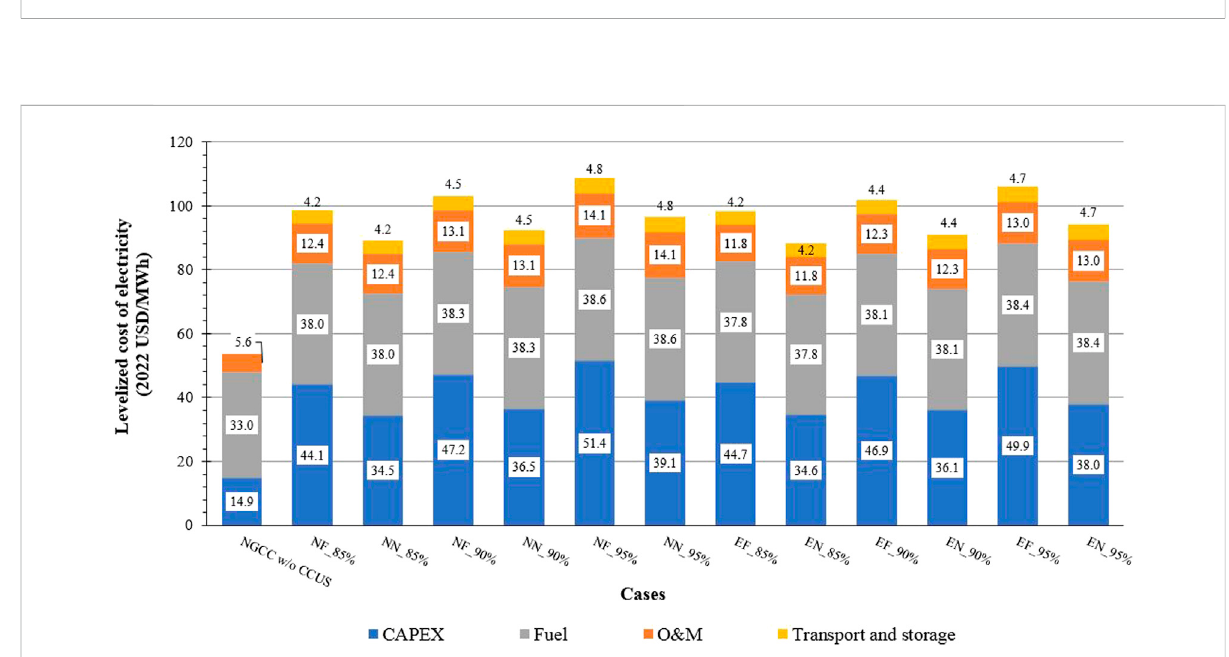
FIGURE 5 LCOE for NGCC and EGR power plants with PCC technology by type of plant at different capture levels.